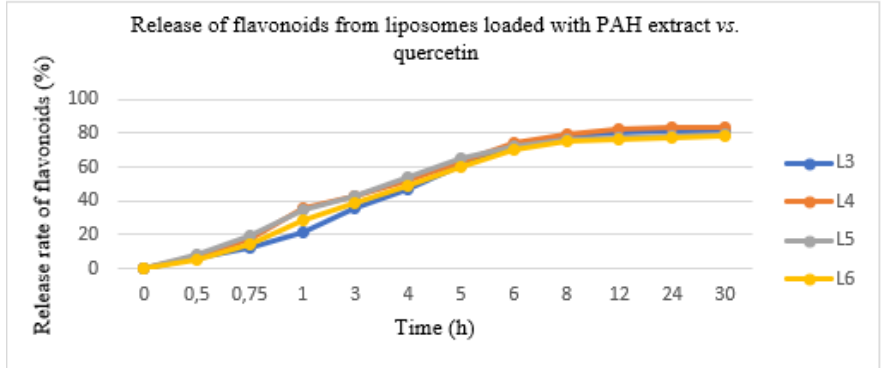
Figure 3. The release of flavonoids from liposomes loaded with the PAH extract (L5 and L6) vs. liposomes loaded with quercetin (L3 and